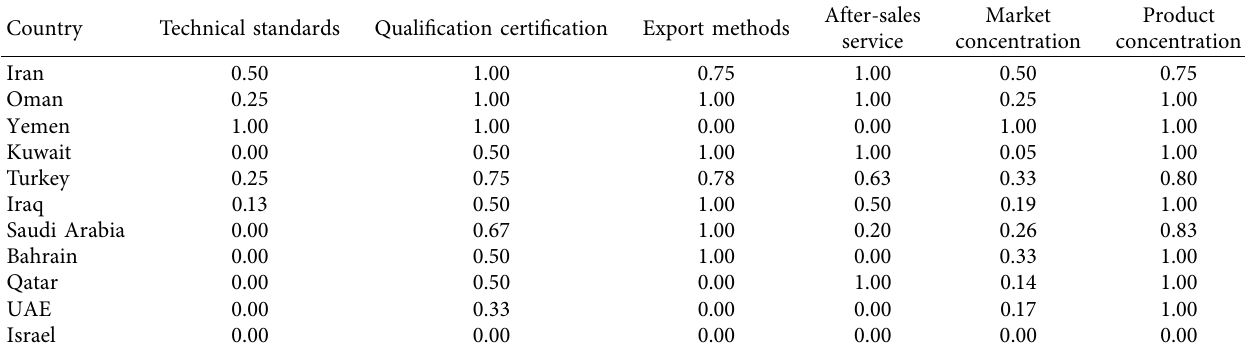
Table 12: Matching indicators value of Chinese power companies in Middle East.